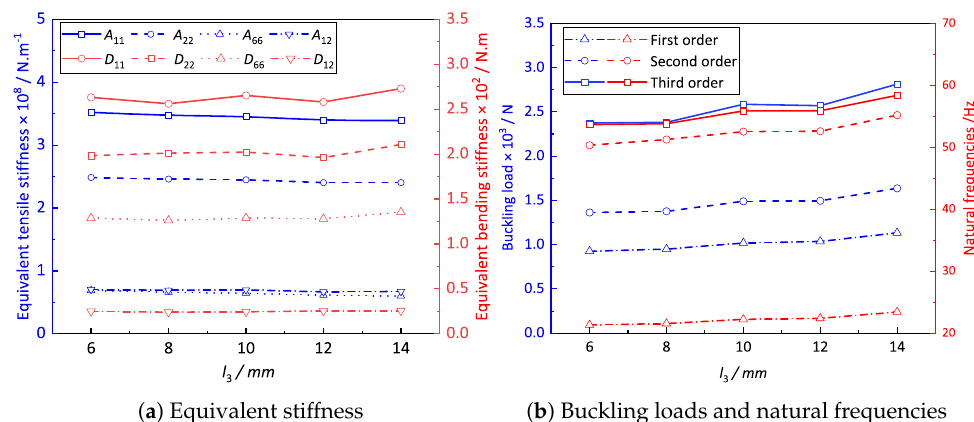
( b ) Buckling loads and natural frequencies Figure 10. The influence of l 3 on the effective performance of CCCP. Figure 11a shows the influence of height h on the equivalent stiffness of CCCP. It can be observed that with the increase in convex height h , the equivalent tensile stiffness of CCCP decreases within a small range. The bending stiffness reaches the minimum value at h = 8 mm and then increases gradually with increasing of h . It can be seen form Figure 11b that the critical buckling load and natural frequency of CCCP increase to a certain extent with increasing of h , indicating the height of the convexity has a certain influence on the overall performance of the structure.